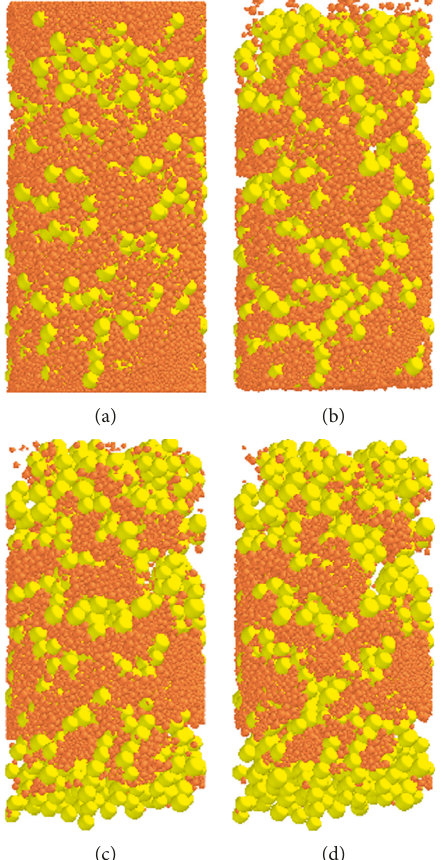
Figure 9: Particles loss under water erosion. (a) t (c) t 0.4 s. (d) t (cid:31)